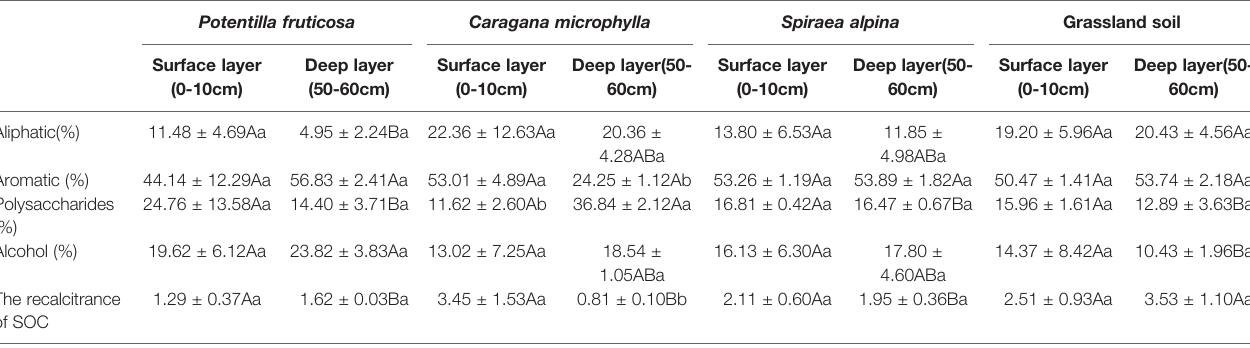
Values are given as mean ± standard error (n=6). Different lowercase letters indicate signi fi cant differences between the different soil layers within the same vegetation types (p < 0.05, independent-samples t-test). Different uppercase letters indicate signi fi cant differences between the different vegetation types within the same soil layers (p < 0.05, Tukey ’ s HSD